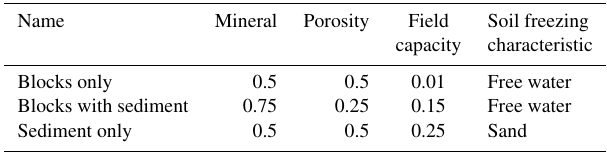
Table 1. Mineral content, porosity and field capacity (all in vol- ume fraction) and soil freezing characteristic for the three idealized subsurface